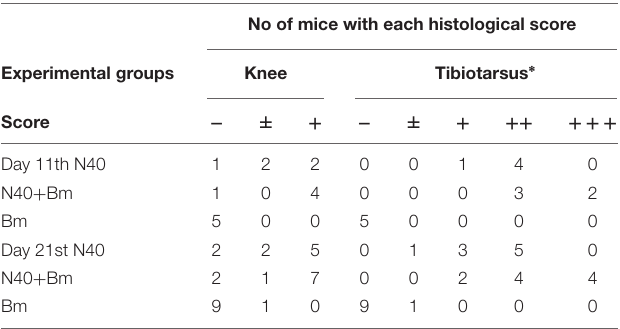
TABLE 2 | Histopathological scoring of joints of infected mice at two points of infection. No of mice with each histological score